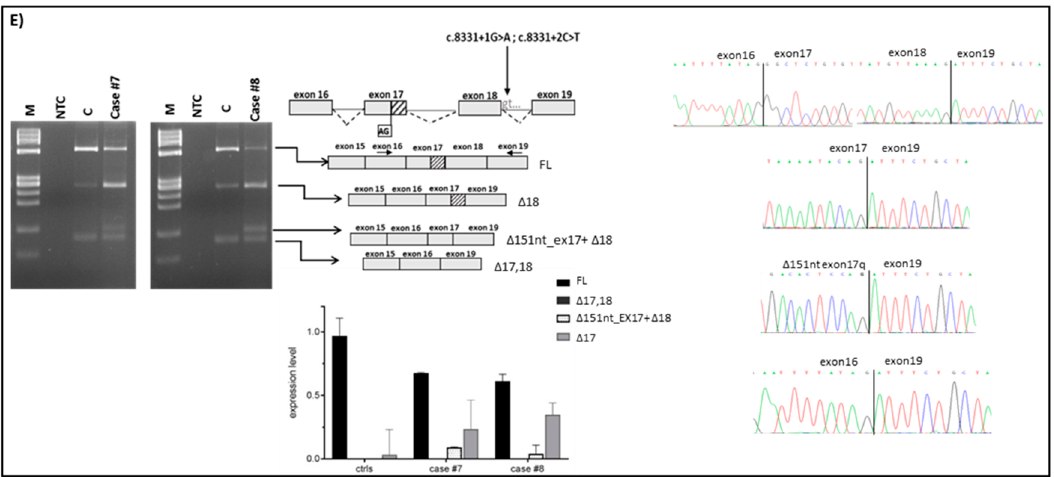
Figure 2. mRNA analysis of spliceogenic BRCA2 variants. Amplified products were separated on 3% agarose gel and independently sequenced. Gel images, graphical representation, and exon–intron junction sequences of full-length (FL) and aberrant transcripts are shown in upper panels. Variants and RT-PCR primers locations are indicated by the arrows. qPCR results are shown as histograms displaying the relative expression of the full-length and aberrant transcript in the patient’s and controls’ samples (lower panels). ( A ) c.476-3C>A, causing the up-regulation of the isoforms lacking exon 6 ( ∆ 6) and exons 5 and 6 ( ∆ 5,6). The ∆ 6 transcript accounts for 0.36 ( ± 0.15) and ∆ 5,6 for 0.23 ( ± 0.15) of overall gene expression in the variant carrier (case #2), and is nearly undetectable in controls. ( B ) c.68-5A>G variant, causing the retention of four nucleotide at the 3’-end of intron 2 ( ∇ 4nt) and the up-regulation of the isoform lacking exon3 ( ∆ 3). The aberrant transcript, detectable exclusively in the variant case (case #3), accounts for 0.34 ( ± 0.3) of overall gene expression. The ∆ 3 isoform accounts for 0.07 ( ± 0.24) of overall gene expression in the variant carrier, 0.08 ( ± 0.08) in the c.68-7T>A sample, and 0.02 ( ± 0.05) in controls. ( C ) c.7618-2A>G variant, causing the deletion of 44 nt at the 5’-end of exon 16 ( ∆ 44nt). The aberrant transcript accounts for 0.10 ( ± 0.24) of overall gene expression in the variant carrier (case #5) and is undetectable in controls. ( D ) c.7806-2A>G, causing three different aberrant transcripts resulting from the deletion of 20 nt at the 5’end of exon 17 ( ∆ 20nt), of 69 nt at the 5’end of exon 17 ( ∆ 69nt) and of whole exon 17 ( ∆ 17). Only the ∆ 20nt transcript is detectable in the variant carrier (case #6) and accounts for 0.11 ( ± 0.06) of overall gene expression and is barely detected in control samples. ( E ) c.8331+1G>A and c.8331+2T>C variants, causing the deletion of 151 nt at the 3’-end of exon 17 and of the whole exon 18 ( ∆ 151nt_ex17 + ∆ 18), and the up-regulation of the isoforms resulting from the deletion of exon 18 ( ∆ 18) and of exons 17 and 18 ( ∆ 17,18). The ∆ 151nt_ex17 + ∆ 18 transcript accounts for 0.09 ( ± 0.001) and 0.04 ( ± 0.06) of overall gene expression in c.8331+1G>A (case #7) and c.8331+2T>C (case #8) samples, respectively, and is undetectable in controls. The ∆ 18 transcript accounts for 0.23 ( ± 0.2), 0.34 ( ± 0.09) and 0.03 ( ± 0.21) of overall gene expression in case #7, case #8 and controls, respectively. The ∆ 17,18 transcript is undetectable in both variant cases and controls. M, molecular weight marker (0.15–2.1 Kbp, Roche and Φ X174 DNA/BsuRI (HaeIII) Marker, Thermo Scientific); C, healthy control sample; NTC, no template control.